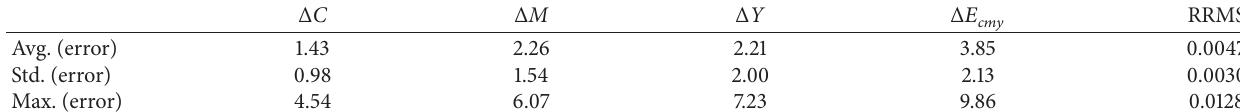
Table 2: The colorant and spectral reflectance error for 50 testing halftone samples.